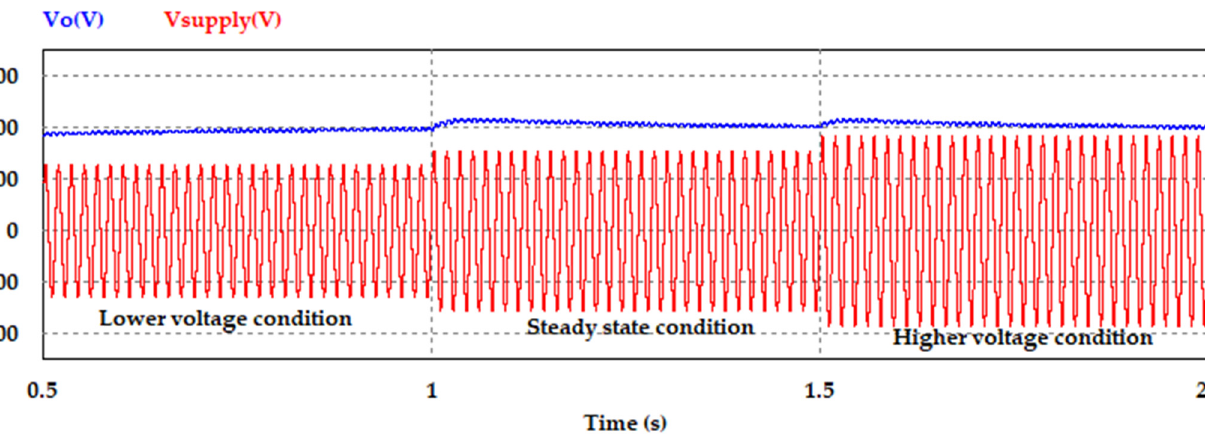
Figure 18. Output voltage dynamic performance with different input voltage for the conventional CCM PFC.